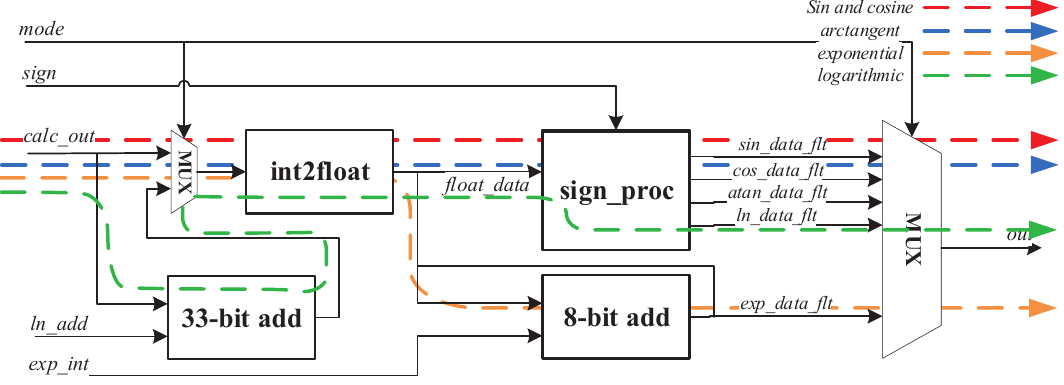
Figure 10. Postprocessing module.